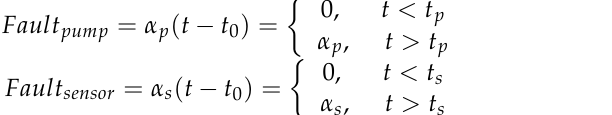
Figure 4. The pump signal for the pipe under no-fault condition.